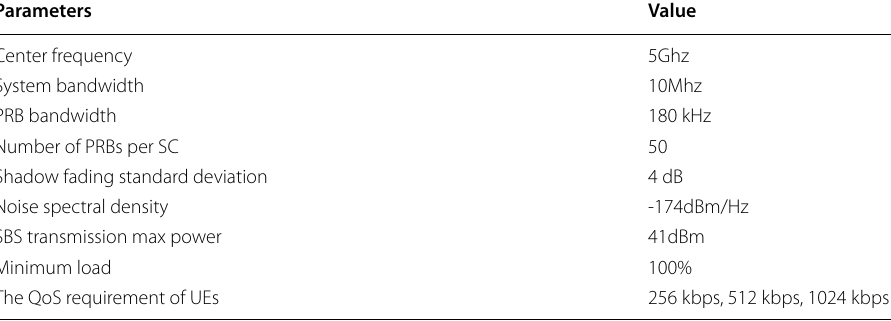
Table 1 Simulation